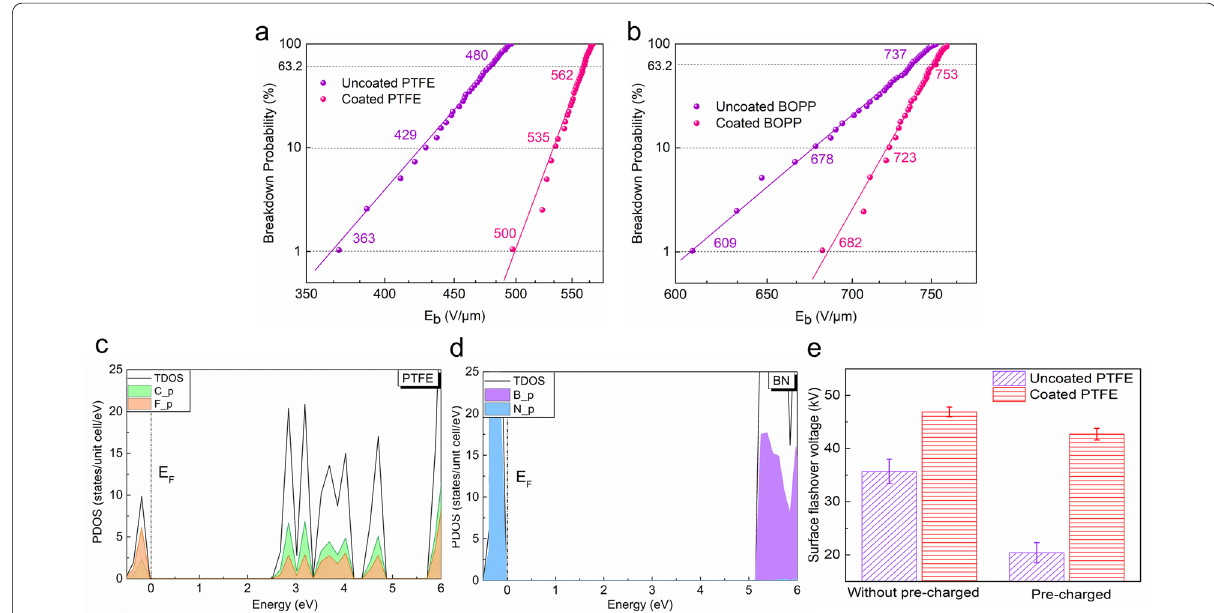
Fig. 2 Breakdown strength test, DFT calculation and flashover voltage. Weibull distribution of breakdown strengths of uncoated and coated a PTFE, b BOPP. Density of state calculated by the HSE SOC method for c the (001) surface of PTFE. d the (001) surface of BN. The Fermi level is set to 0. e + Flashover voltage of coated and uncoated